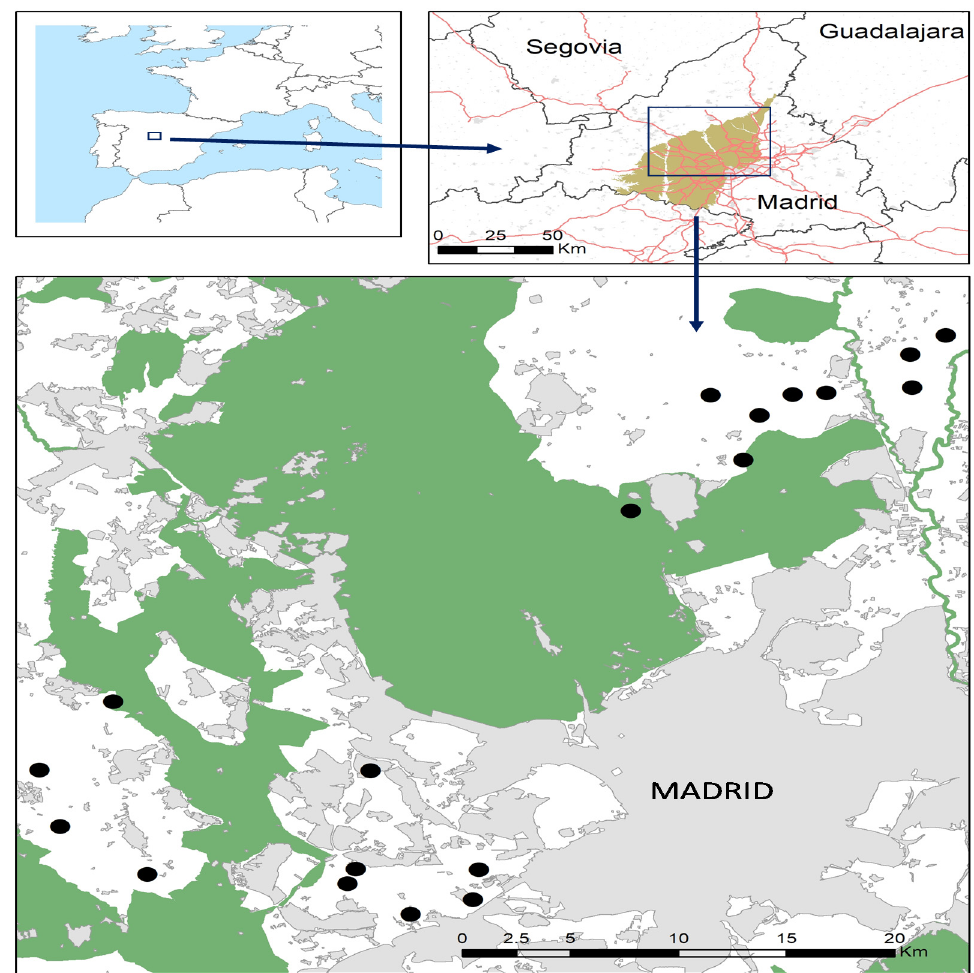
Figure 2. Study area: general location maps ( above ) and local situation of transects (black dots) around Madrid ( below ). In the latter figure, Natura 2000 sites are depicted in green and grey areas correspond with urban areas (Madrid city and its conurbation).